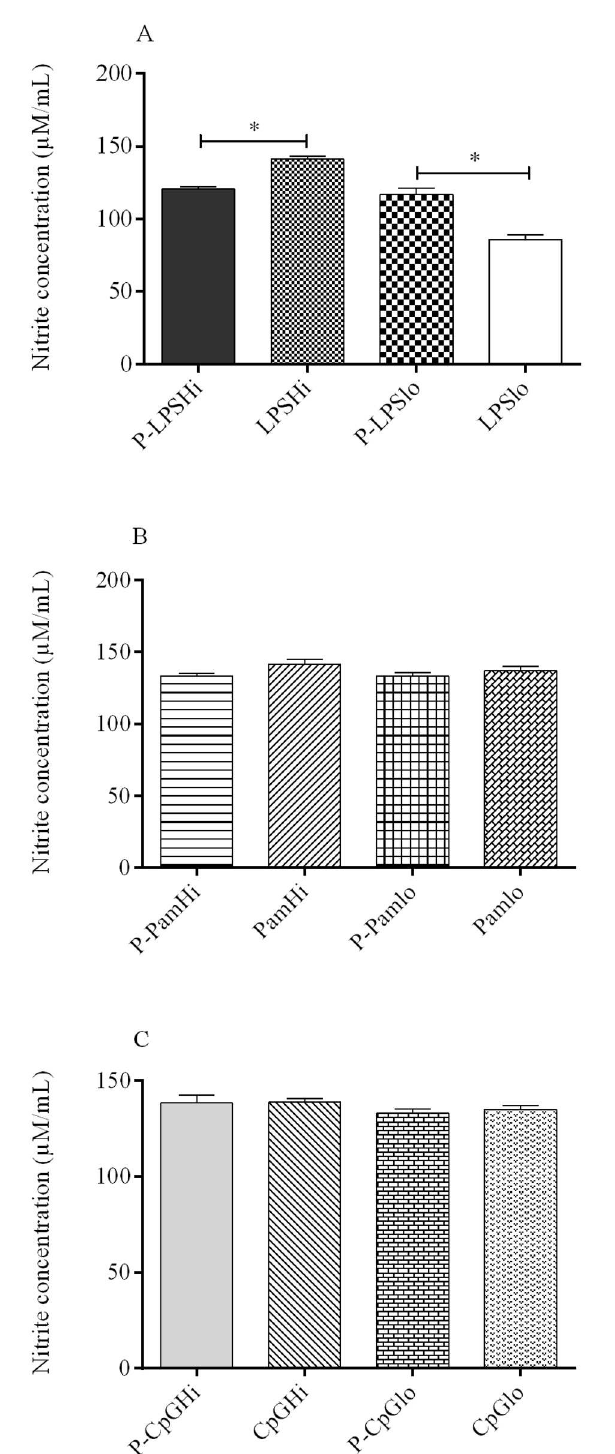
Fig 1. Nitric oxide (NO) production from chicken macrophages (six replicates/group) stimulated with encapsulated and soluble forms of three TLR ligands, measuredby Griess reagent system. (A). LPS; (B). Pam3CSK4, and (C). CpG ODN. Significance ( P < 0.05) betweendeliverysystems (encapsulated and solubleTLR ligands) within a treatment dose was determined.P-LPSHi—encapsulated high dose LPS; P-LPSlo—encapsulated low dose LPS; LPSHi—solublehigh dose LPS; LPSlo—solublelow dose